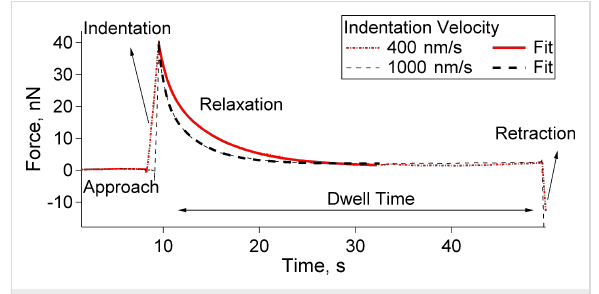
Figure 9: Stress relaxation curve with a dwell time of 40 s. The biexpo- nential fit is represented by the thick lines on the decaying part of the force curve, in the dwell